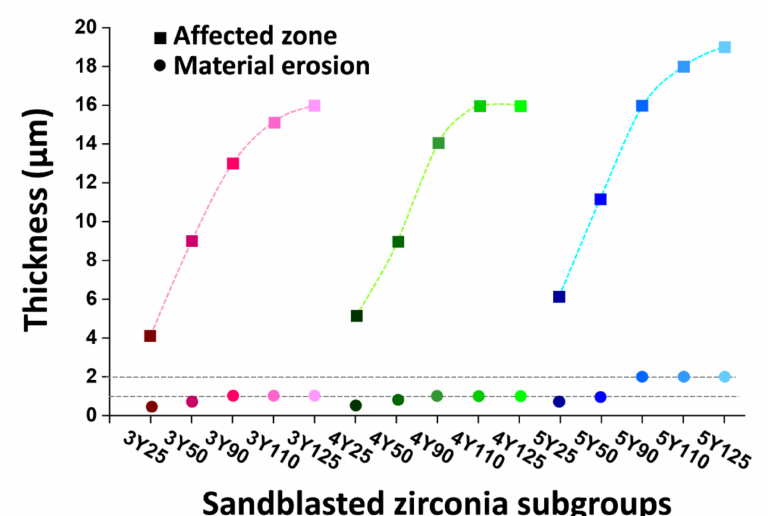
Figure 12. Thicknesses of the affected stress layers and the material cuts below the impact zones for the finite element modeling of all zirconia grades. 5Y subgroup models showed the deeper impact cuts at the contact zone compared to 3Y or 4Y subgroup